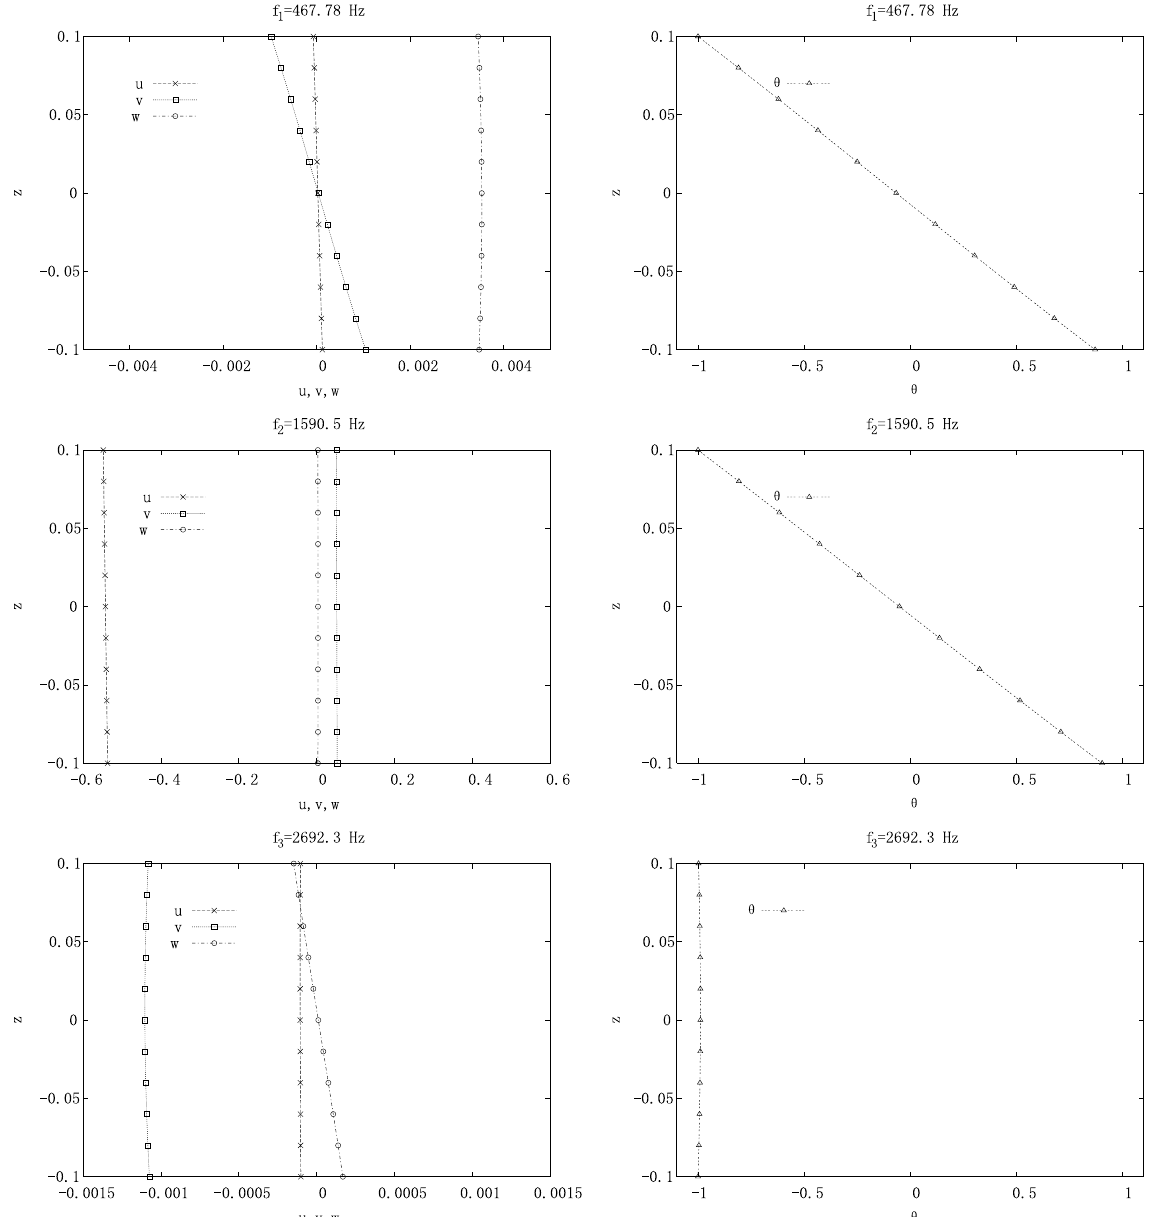
Fig. 5. One-layered isotropic shell, m = n = 1 and R α /h = 50. First three modes in terms of displacements and sovra-temperature. LD4(TM) model. the thermo-mechanical coupling introduces different effects when all the vibration modes for fi xed values of wave number are considered. Tables 8 and 9 give all the frequencies related to the degrees of freedom of the employed two-dimensional theory (see Table 1) for three different values of the wave numbers ( m = n = 1, m = n = 10 and m = n = 10000). Table 8 is for the one-layered shell: CLT gives three frequencies, FSDT gives fi ve frequencies and LD4 gives 15 frequencies. Table 9 is for the two-layered plate: only the LD4 theory has been investigated and it gives 27 frequencies for each pair of m and n . From Tables 8 and 9, it is clear that: when all the frequencies are considered (not only the fundamental one), the thermo-mechanical coupling does not depend on the considered wave